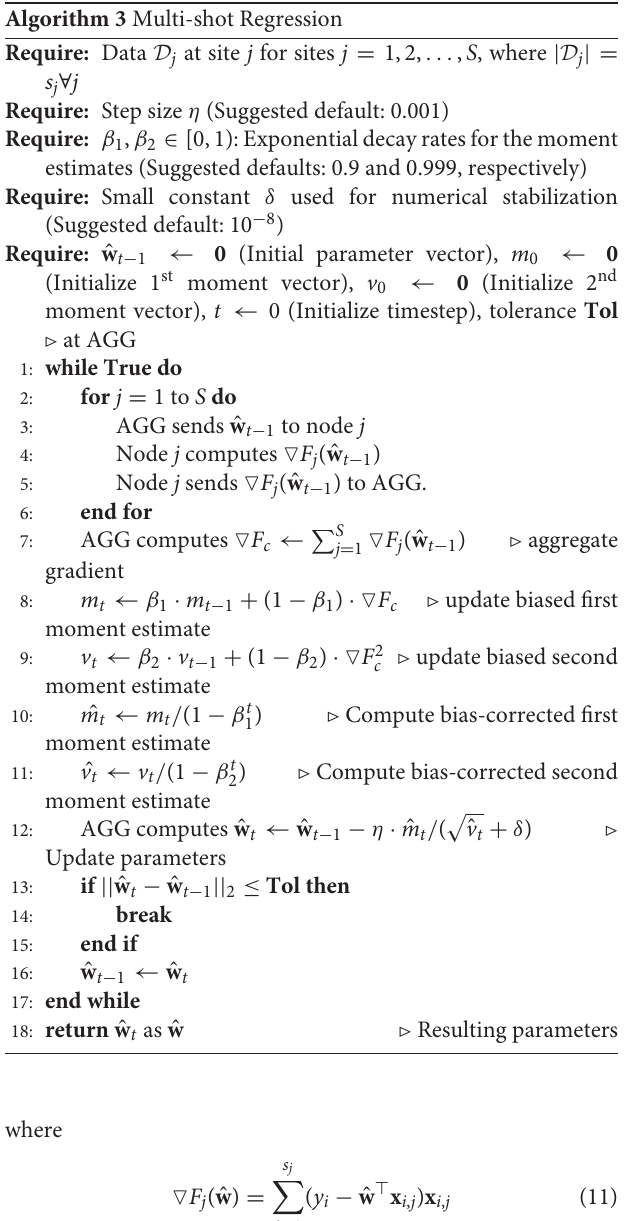
Algorithm 3 Multi-shot